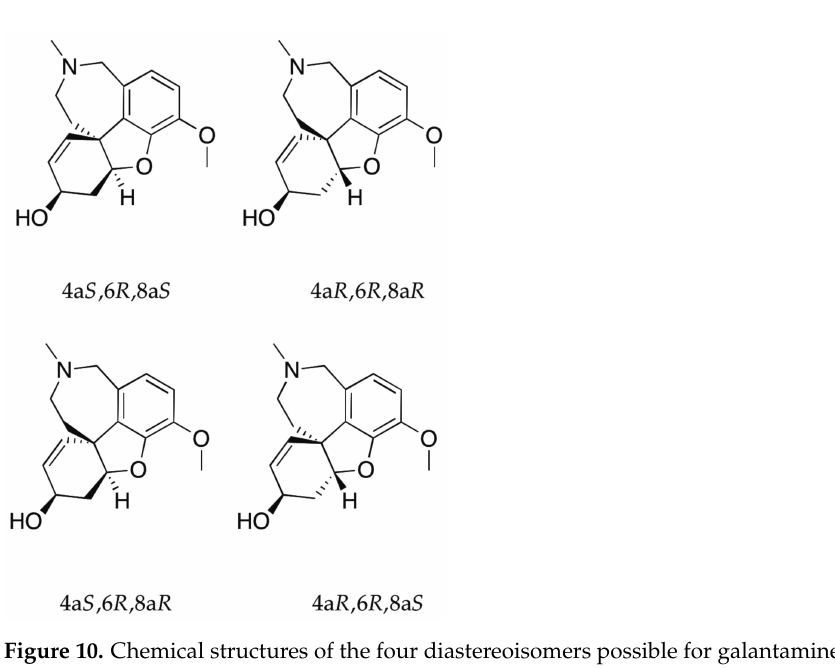
Figure 9. Comparison of the experimental (sample B) and simulated Raman and ROA spectra of the (3 R ,4 S )- and (3 S ,4 S )-diastereoisomer of the 1-BOC-3-TES-4-Ph-azetidin-2-one precursor studied. Reprinted with permission from ref. [46]. Copyright 2017 American Chemical Society.